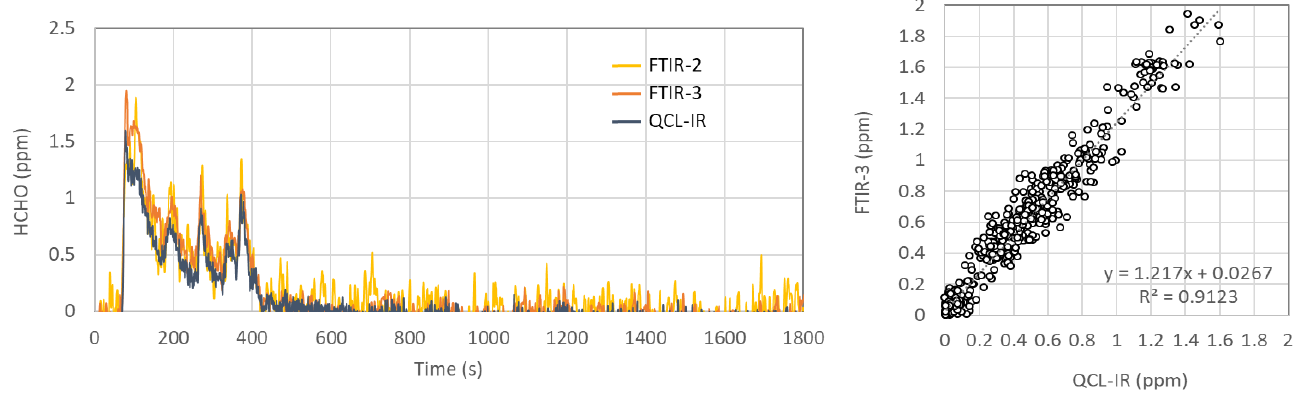
Figure 6. ( Left panel ) HCHO emission profiles of the HDV during the WHVC at 5 °C. ( Right panel ) Correlation of the HCHO concentrations measured by FTIR-3 and the QCL-IR from the HDV during the first 450 s of the WHVC at 5 °C.